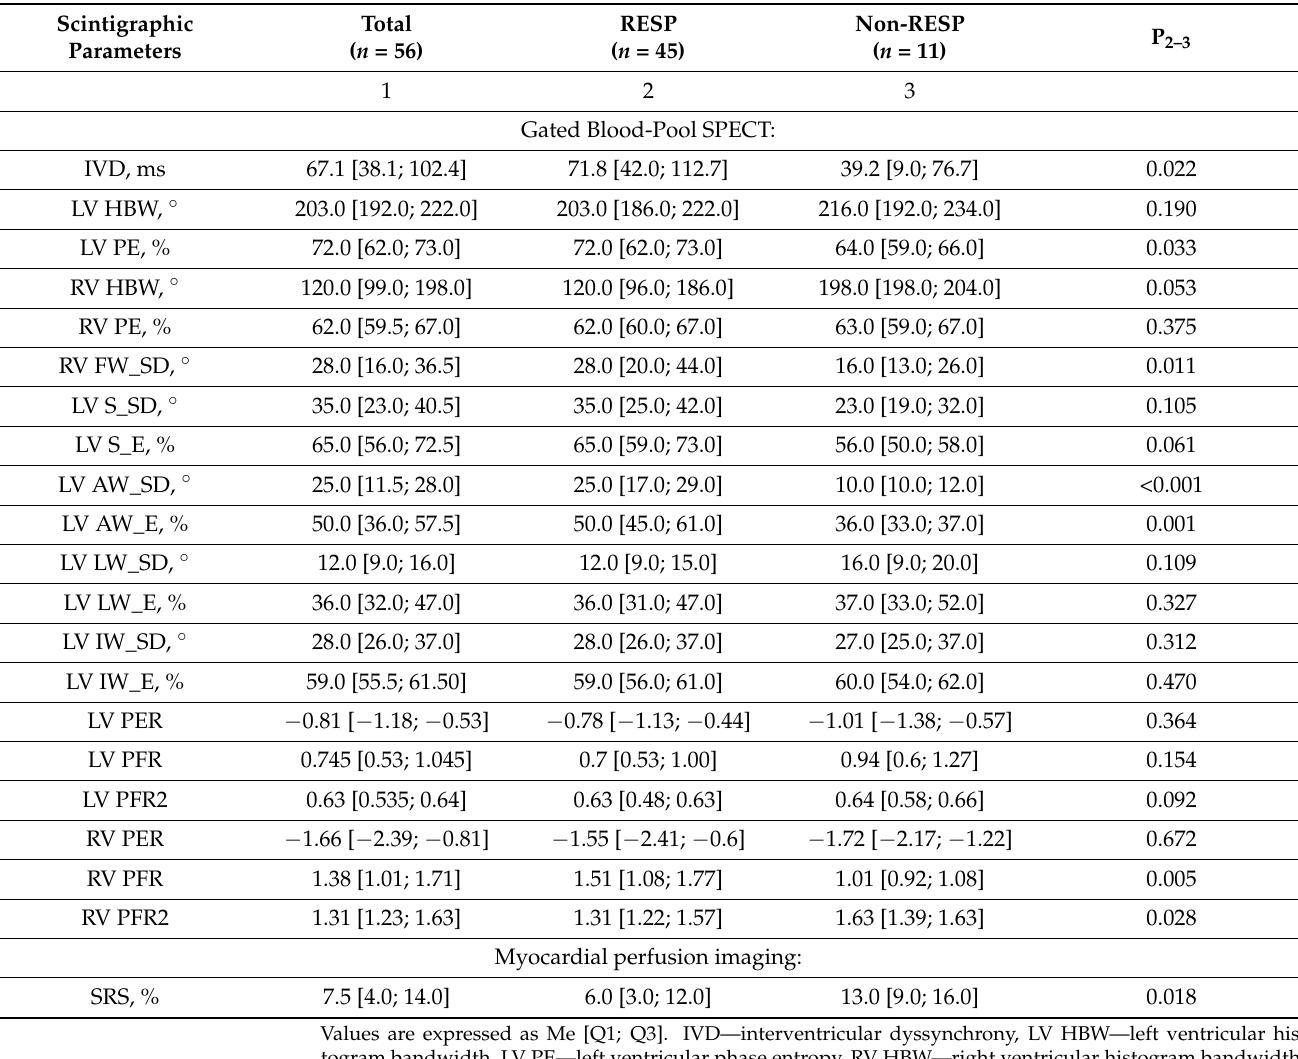
Table 2. Scintigraphic characteristics before CRT-D